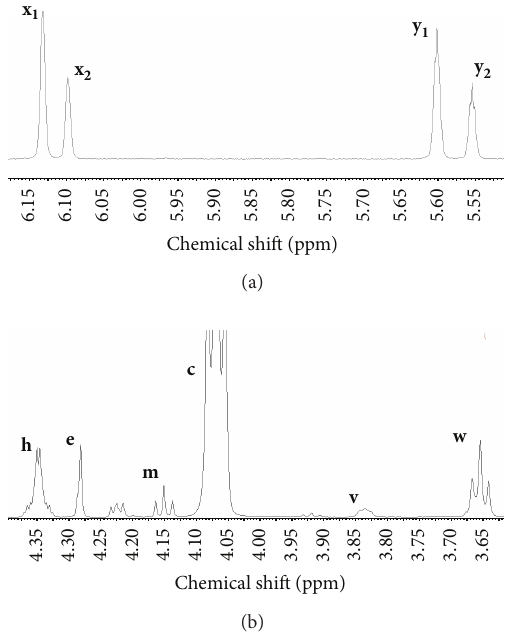
Figure 4: 1 H NMR demonstration of the dried macromonomer synthesized at 70 ∘ C, 6h, 100mg Novozyme-435, 0.3 HEMA/CL (mmole/mmole), and 45 mmole